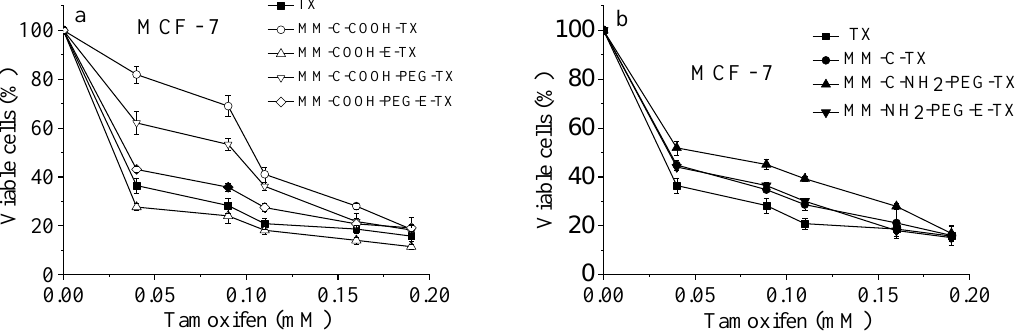
Figure 9. Cytotoxicity of free tamoxifen drug and its silica-loaded varieties: ( a ) COOH-modified and ( b ) NH 2 -modified nanoporous MM silica composites after 72 h continuous exposure at 37 °С. Each data point represents the arithmetic mean SD of 6 separate experiments.